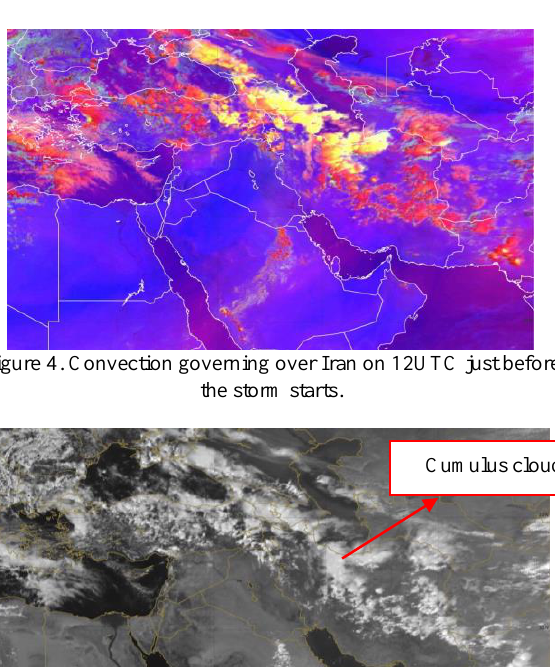
Figure 3. MODIS aerosol optical depth on 550nm on second of June 2014.